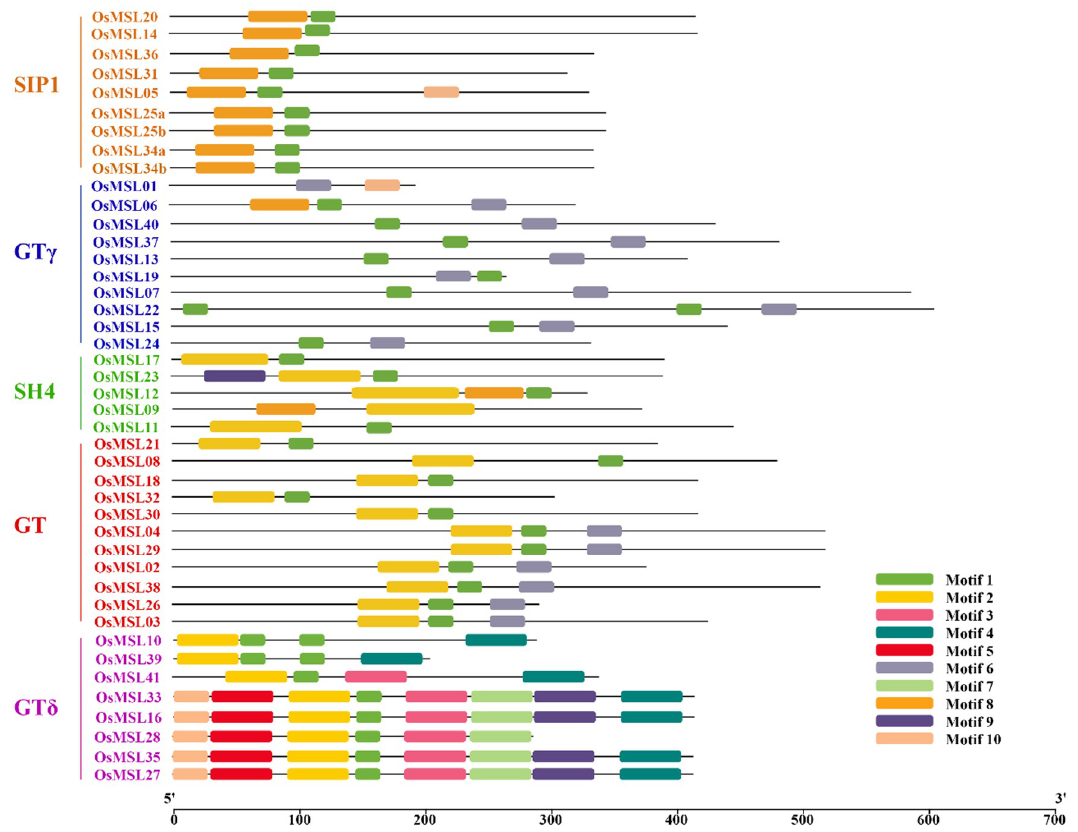
Figure 6. Motif composition of rice trihelix proteins. Motif analysis was performed using the MEME program as described in the methods section. The trihelix proteins are listed on the left. Boxes of different colors represent the various motifs. Their location in each sequence is marked. Motif sequences are shown in Figure S2. The scale bar at the bottom indicates the lengths of the trihelix protein sequences.